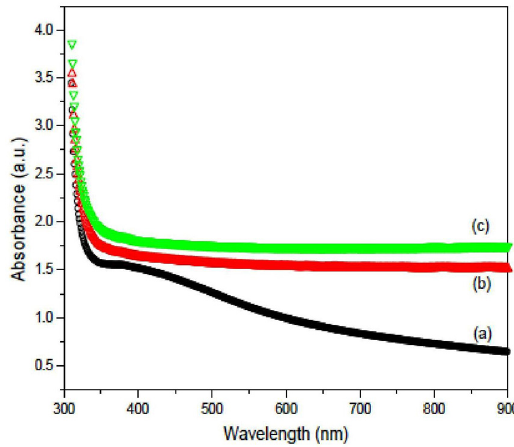
Figure 6: Absorbance versus photon wavelength for (a) ZnS , (b) 2.5% Sn: ZnS and (c) 5% Sn: ZnS